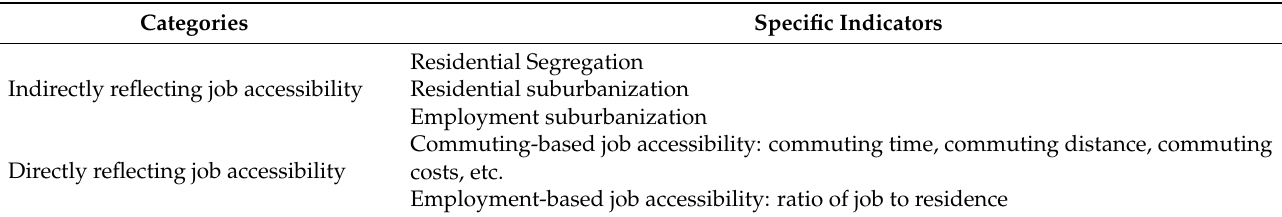
Table 2. Category of spatial relationship measurement